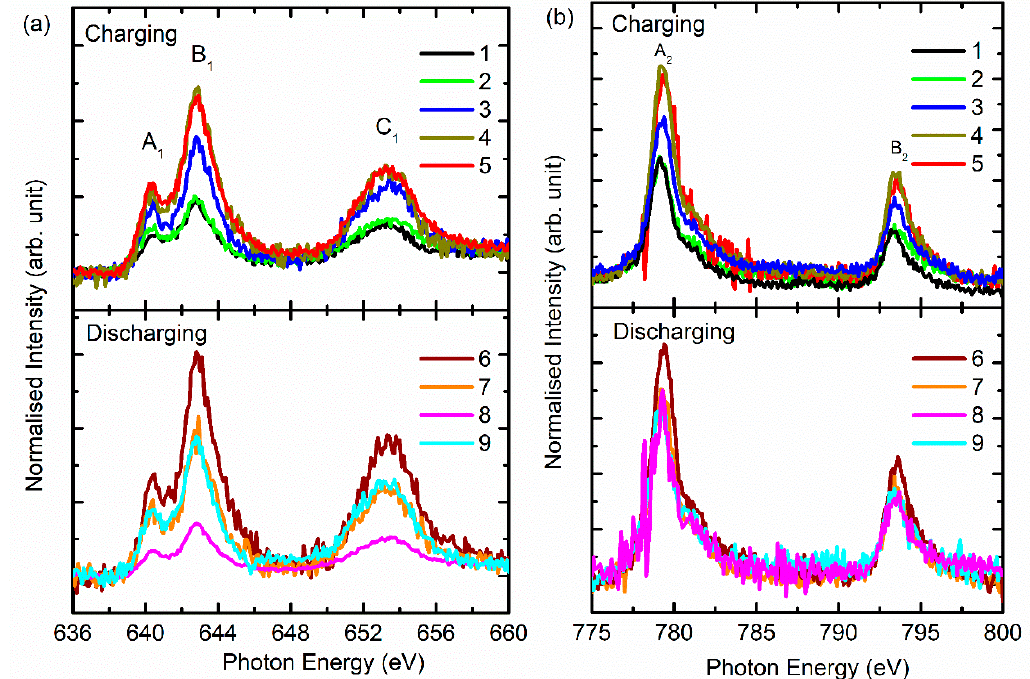
Figure 5. ( a ) Mn L -edge and ( b ) Co L -edge near-edge X-ray absorption fine structures (NEXAFS) spectra of NCM811 cathode material during charging and discharging. Nanomaterials 2020 , 10 , x FOR PEER REVIEW